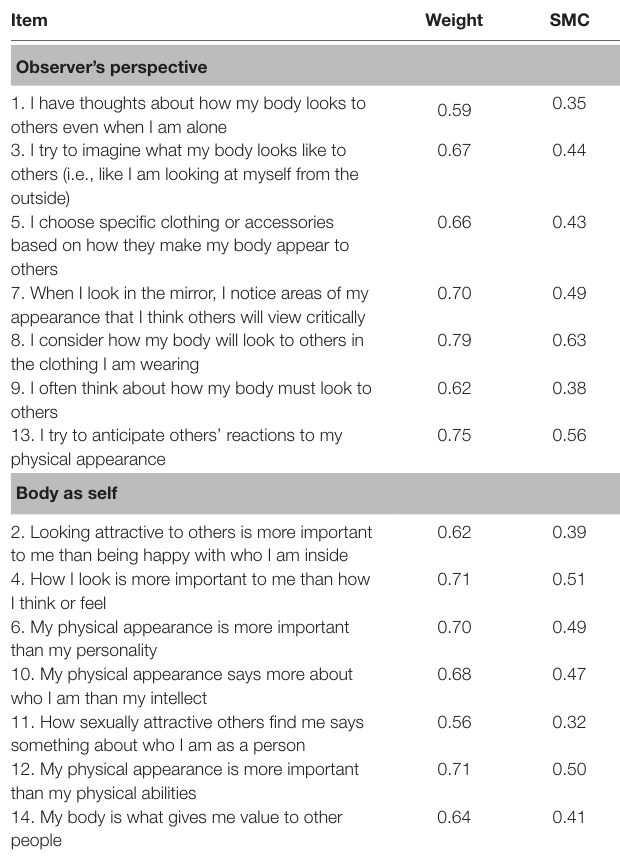
TABLE 2 | Item standardized regression weights, squared multiple correlations (SMC), and item descriptive statistics for the C-SOBBS ( n = 331).